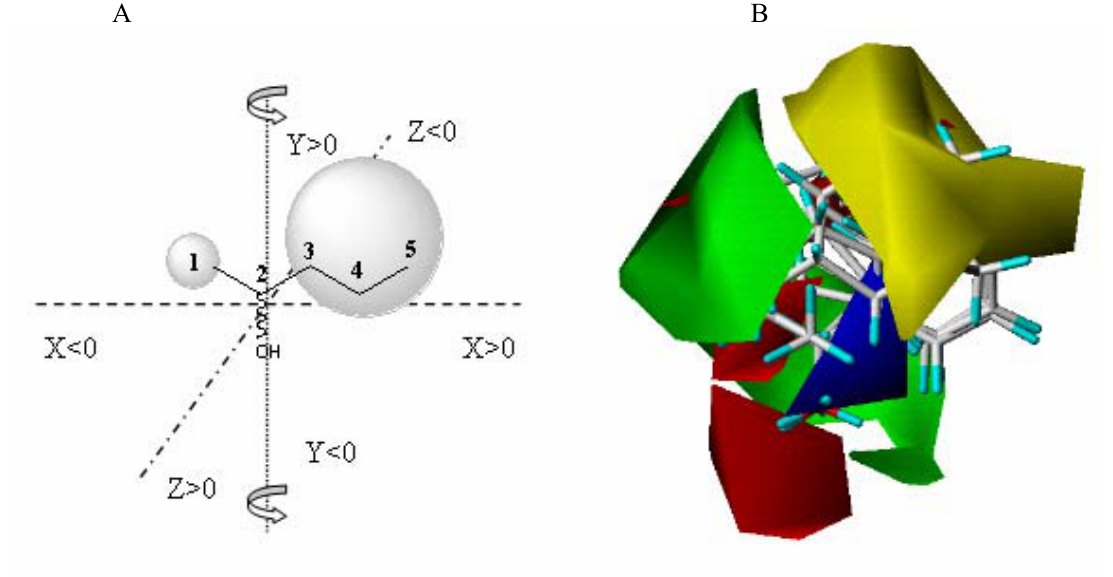
Figure 3. (Figure A): Fitting criterion used for alignment of the conformers of the molecules in CoMFA analysis and the alcohol oxidation biocatalysts CoMFA model. In the CoMFA model (Figure B) the steric hindrance zones (yellow and green) and electrostatic zones (red and blue) are shown. The color code used in the figure is as follows: Steric hindrance zones : Green areas depict zones of space where occupancy by the substrates increases affinity, whereas yellow areas depict zones where occupancy decreases affinity. Electrostatic zones : areas where a high electron density provided by the ligand increases (red) or decreases (blue) the